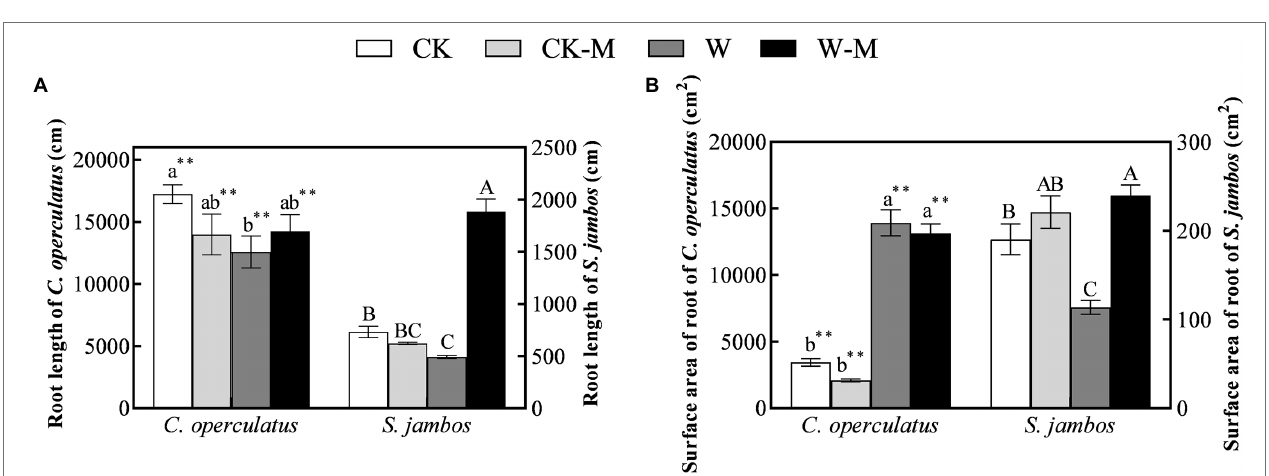
FIGURE 2 | The variations of root length (A) and root surface area (B) in C. operculatus and S. jambos among different treatments. Values are means ± SE ( n = 6). Different little and capital letters indicate significant differences among different treatments within the same species according to ANOVA’s test ( p < 0.05). CK, pure planting pattern under well-watered condition; CK-M, mixed planting pattern under well-watered condition; W, pure planting pattern under waterlogging condition, W-M; mixed planting pattern under waterlogging condition. The sign ** concerns the significance difference between the two species under the same treatment. ** p <